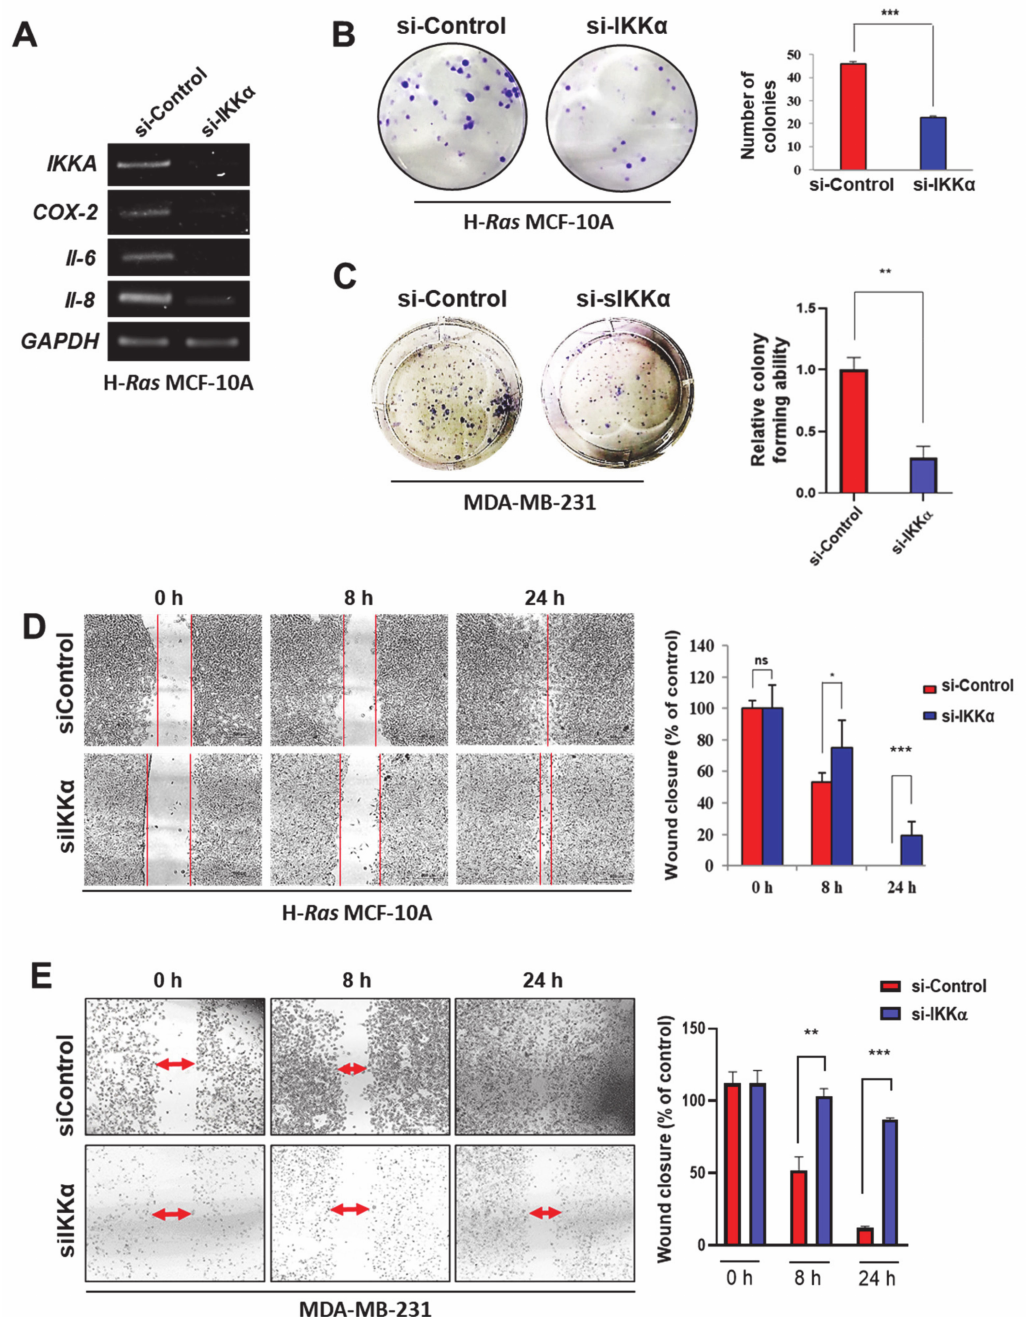
Figure 2. IKK α knockdown suppresses tumorigenesis in H- Ras MCF-10A and MDA-MB-231 cells. ( A ) RT-PCR analysis of IKK α , IL-6 , IL-8 , and COX-2 mRNA expression in H- Ras MCF-10A cells transfected with si-Control or si-IKK α for 48 h. GAPDH, an equal loading control for PCR. ( B , C ) H- Ras MCF-10A ( B ) and MDA-MB-231 ( C ) cells were plated in a 6-well plate and incubated with si-Control or si-IKK α for 7 days. Then, the colonies were stained with 0.5% crystal violet. The number of colonies was counted and presented as a bar graph. ** p < 0.01 ( n = 3). ( D , E ) H- Ras MCF-10A ( D ) and MDA-MB-231 ( E ) cells were seeded in an ibidi culture insert and then transfected with si-Control or si-IKK α for 48 h. The progression of cell migration was visualized under the microscope and presented as a bar graph. ns, not significant; * p < 0.05; ** p < 0.01; *** p < 0.001 ( n =